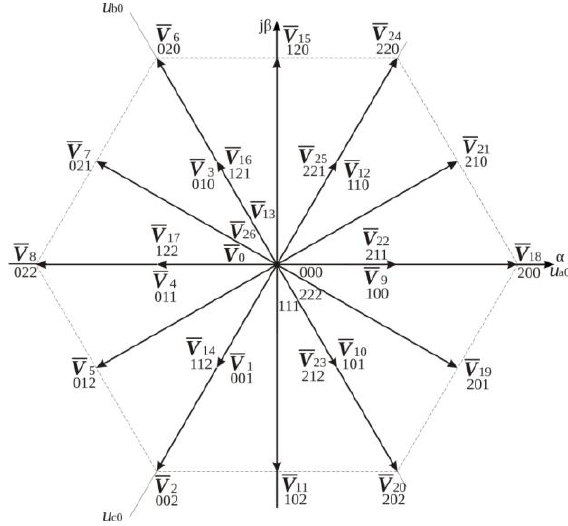
Figure 5. Polar voltage space vectors of the three-level VSI (Voltage Source Inverter).